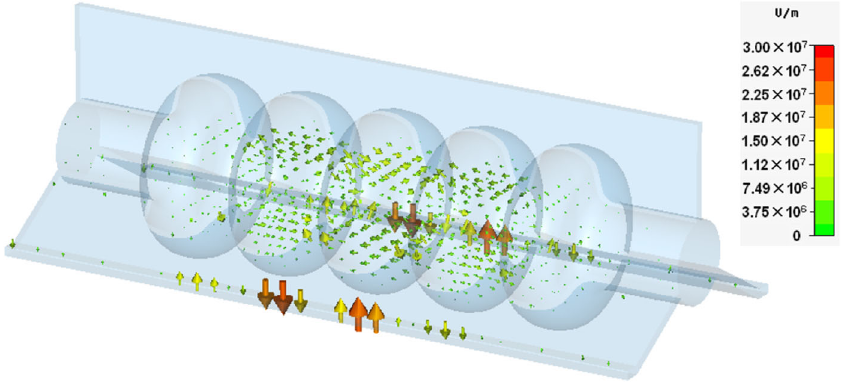
FIG. 4. (Color) E -field of a dipole mode in the slotted cavity. Frequency ¼ 1 : 947 99 GHz , Q e ¼ 137 : 8 , R=Q ¼ 18 : 4(cid:1) . The electric field is derived by assuming 1 J stored energy of this dipole mode in the cavity.